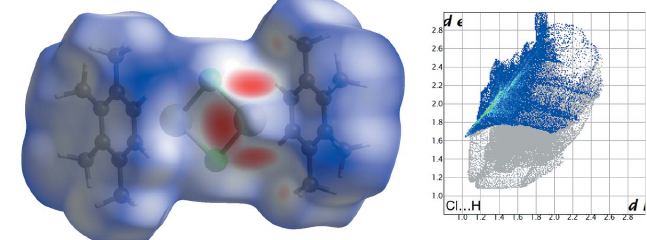
Figure 5 Three-dimensional Hirshfeld ( d norm ) surface for the [(1,2,3,4-tetramethyl- benzene) 2 Sn 2 Cl 2 ] 2+ moiety of 1 (left) and two-dimensional fingerprint plot for the H (cid:4)(cid:4)(cid:4) Cl contacts (right); prepared using CrystalExplorer17.5 (Turner et al. , 2017). The characteristic feature in the fingerprint plot mainly corresponds to the contacts C10—H103 (cid:4)(cid:4)(cid:4) Cl3 {C—H 0.97 A˚ , H (cid:4)(cid:4)(cid:4) Cl 2.79 [2.74] A˚ , C—H (cid:4)(cid:4)(cid:4) Cl 146.3 [149.4] (cid:2) , C (cid:4)(cid:4)(cid:4) Cl 3.633 (3) [3.605 (4)] A˚ } and C7—H71 (cid:4)(cid:4)(cid:4) Cl4 ii {C—H 0.97 A˚ , H (cid:4)(cid:4)(cid:4) Cl 2.80 [2.78] A˚ , C—H (cid:4)(cid:4)(cid:4) Cl 143.6 [144.1] (cid:2) , C (cid:4)(cid:4)(cid:4) Cl 3.622 (3) [3.612 (4)] A˚ }; values for 2 given in square brackets.